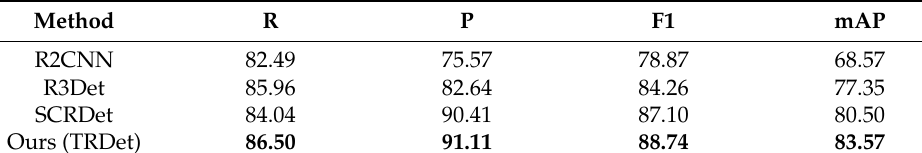
Table 5. Performance comparison of the RD task.